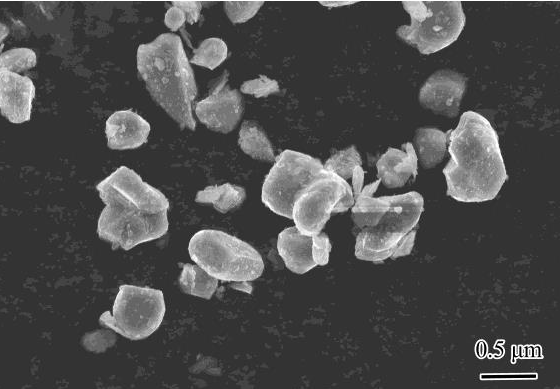
Figure 4. TiB 2 single particle with particle size of 0.4 μm–0.6 μm in dry air medium at ambient temperature.